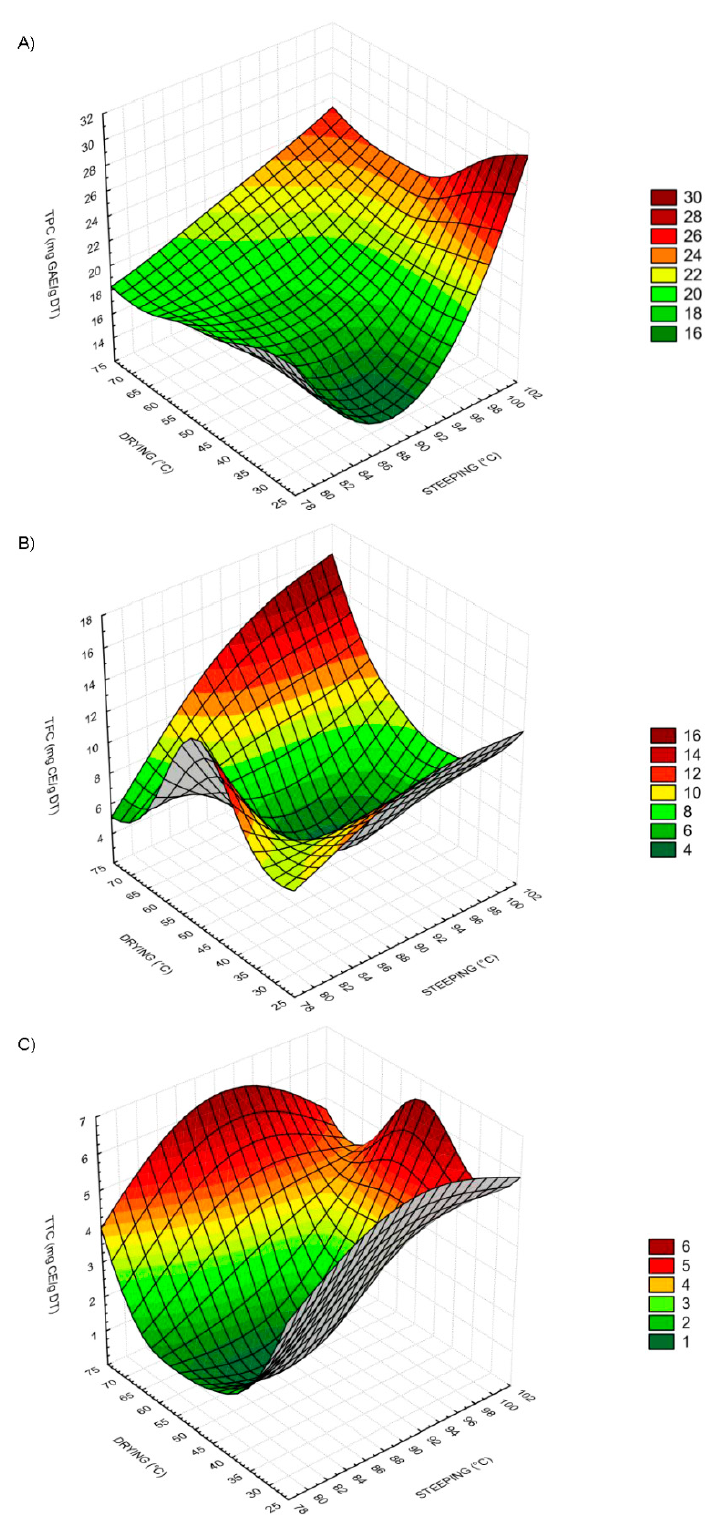
Figure 2. Interaction effect of different drying and steeping temperatures on ( A ) total phenolic content (TPC), ( B ) total flavonoid content, and ( C ) total tannins content of infusions obtained from flowers and leaves of Cunila polyantha .